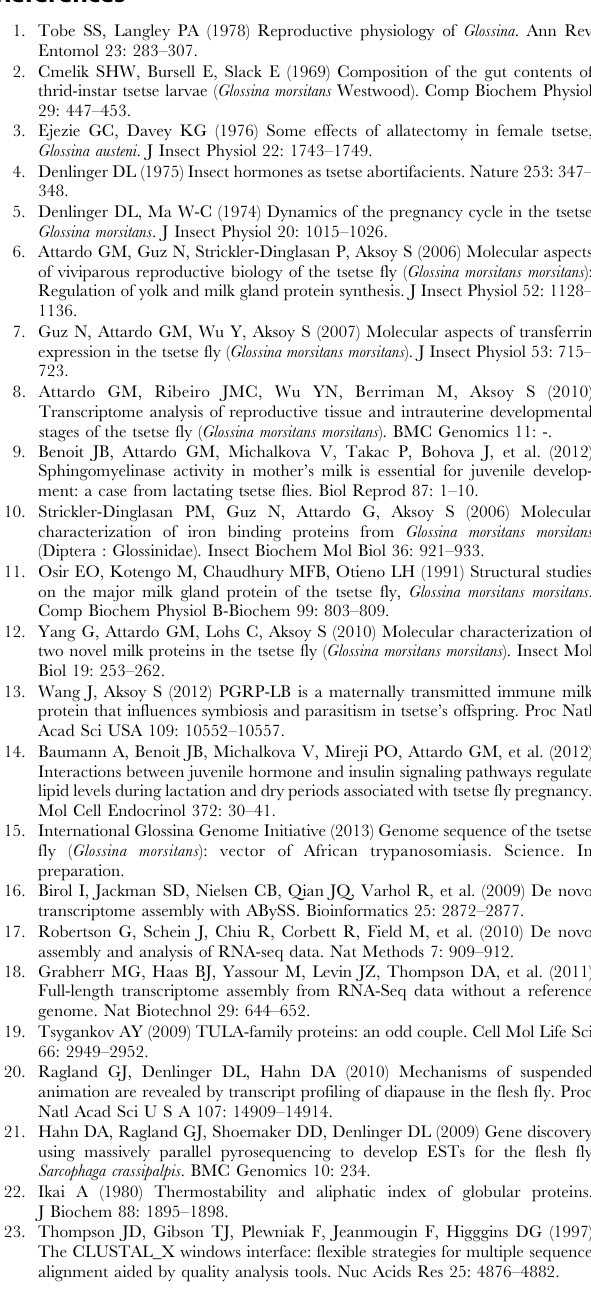
between RNA-seq and qPCR fold changes between dry and lactating